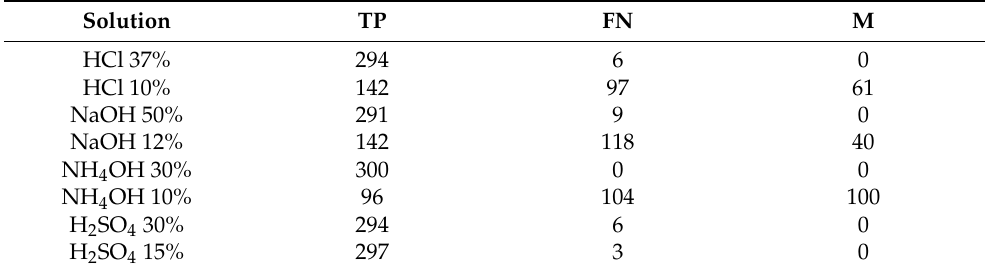
Table 4. Classification of corrosive solutions scanned through the walls of transparent and coloured